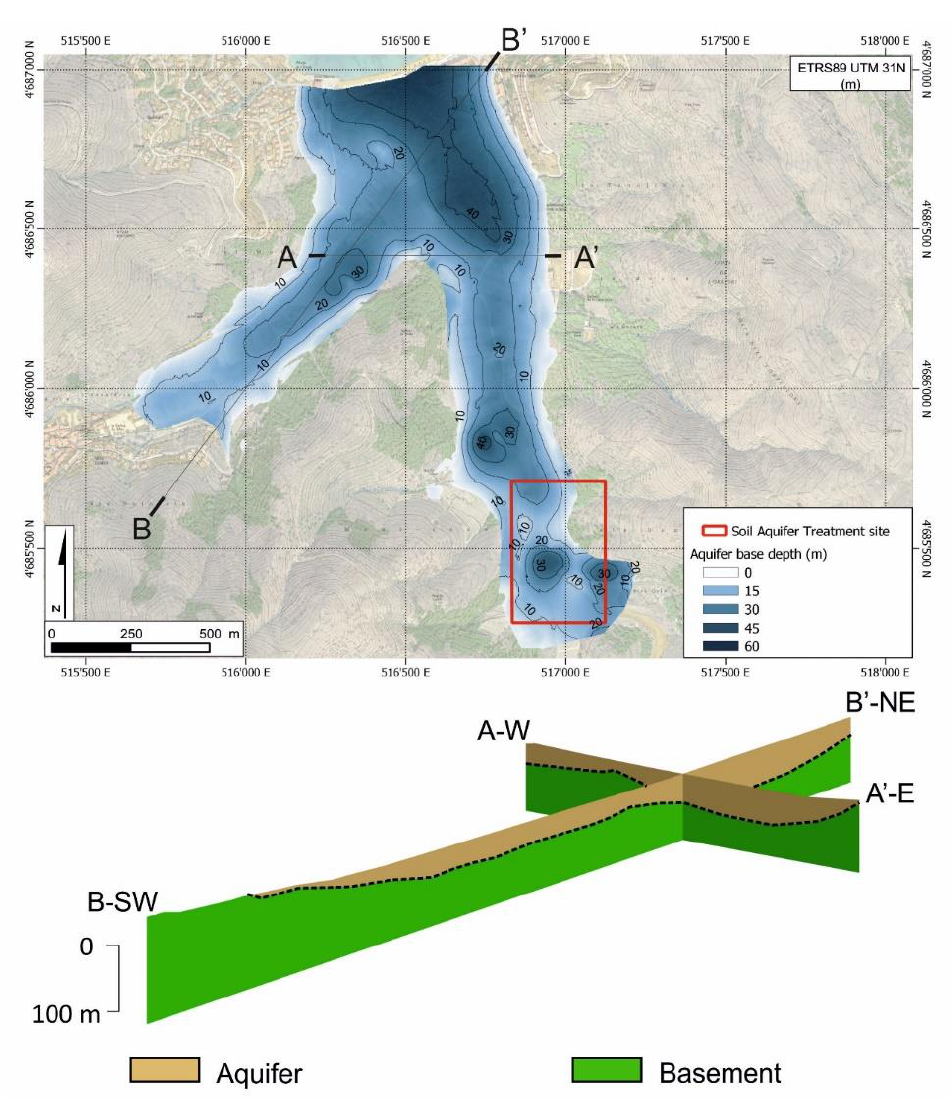
Figure 6. Shallow aquifer base depth model inferred from ERT and borehole data (Port de la Selva, Spain).